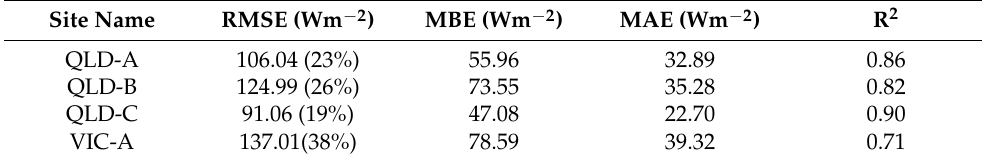
Table 6. Error metrics for predicted mean GHI ensemble at advection of 5